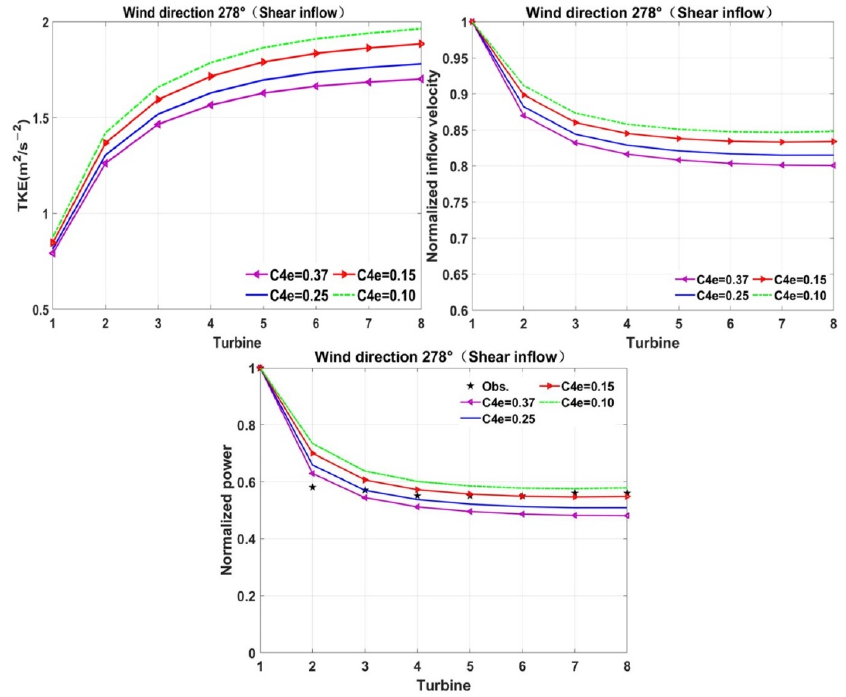
Figure 18. Effects of different C 4 ε values on TKE, inflow wind speed and power output under shear inflow conditions when the incoming wind direction is 278° and the undisturbed inlet velocity is 8 m/s.